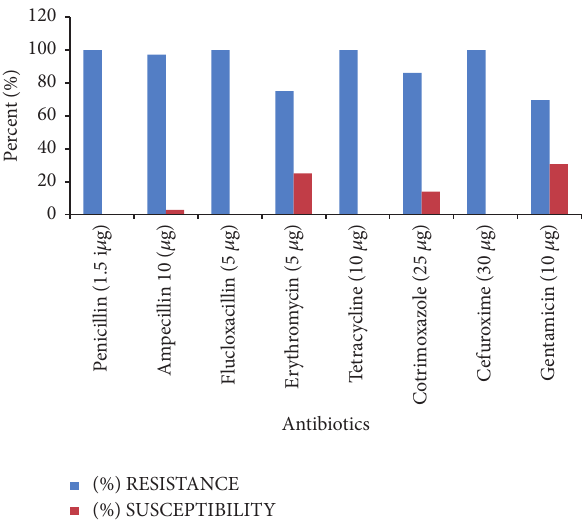
Figure 3: A graph showing percentage resistance and susceptibility of S. aureus